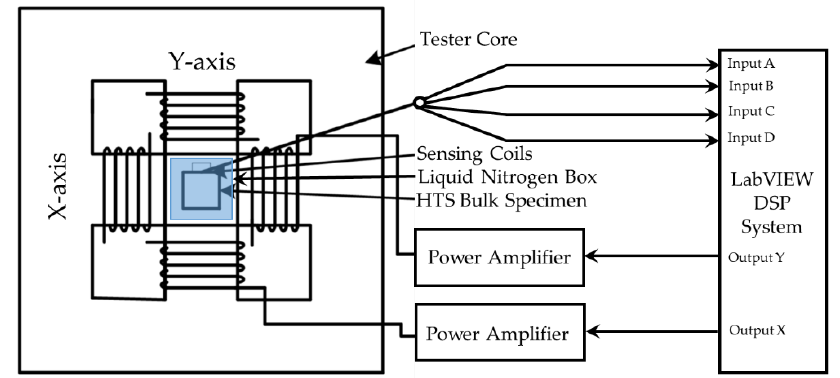
Figure 1. Equivalent block diagram of square specimen tester